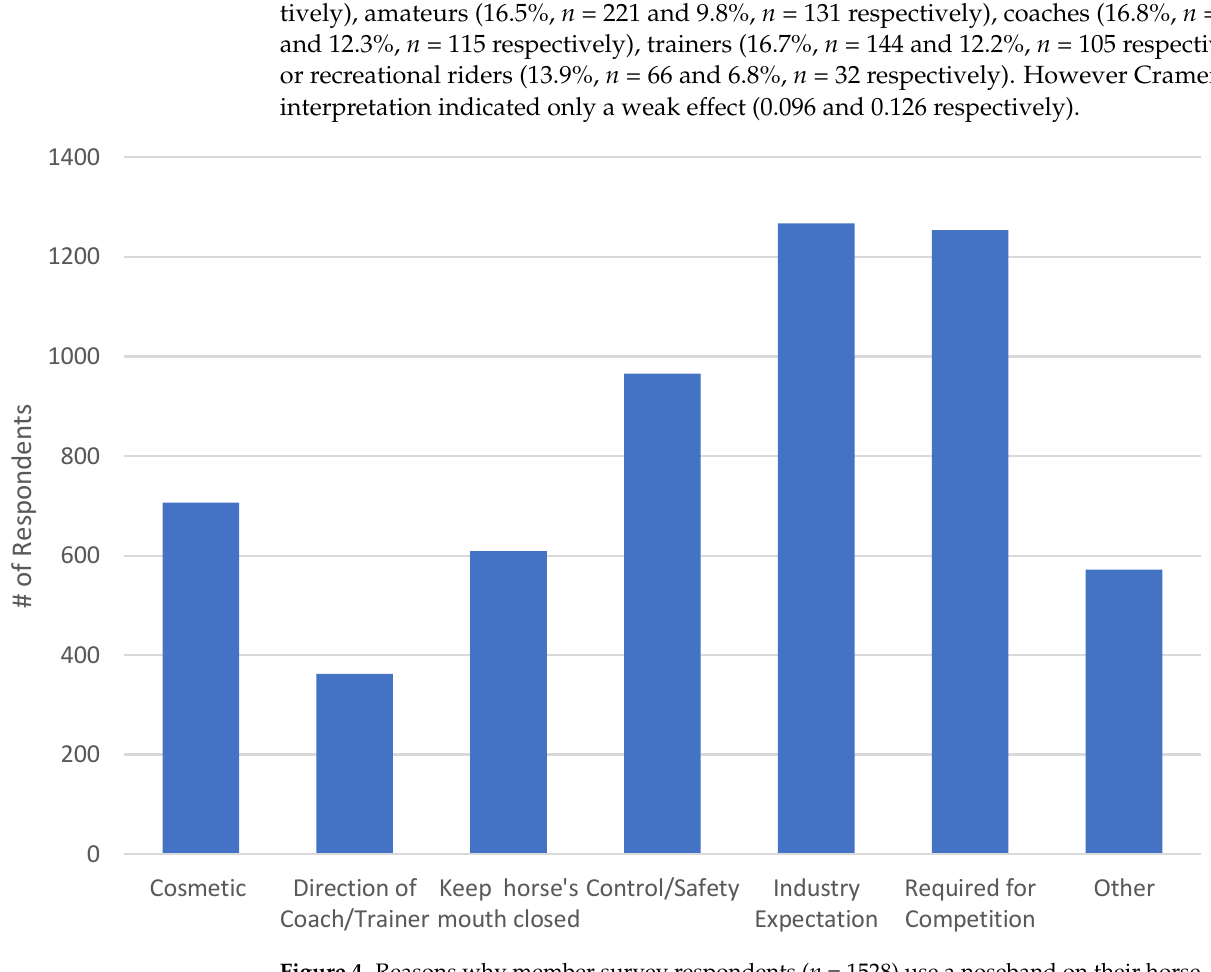
Figure 4. Reasons why member survey respondents ( n = 1528) use a noseband on their horse. Note that respondents could select multiple reasons.